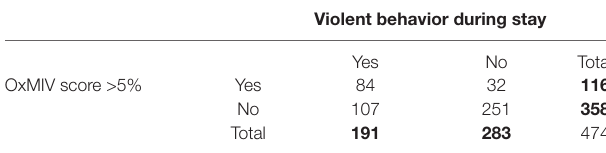
OxMIV, Oxford Mental Illness and Violence